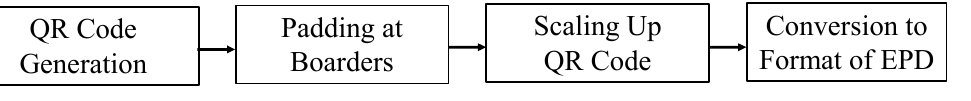
Figure 4. Processing and displaying QR code.